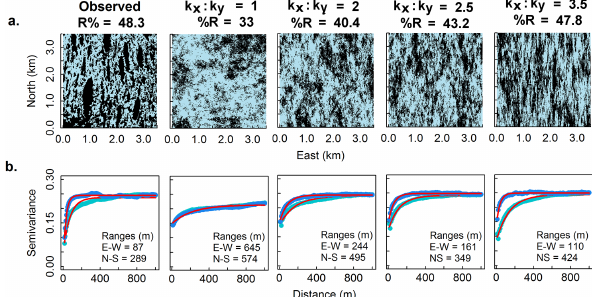
Figure 4. (a) Example reference and simulated landscapes (black: ridge; blue: slough) for ky = 0 . 2 and kx : ky = 1, 2, 2.5, and 3.5, (b) indicator semivariograms (blue: east–west; green: north–south; red: exponential model fit).